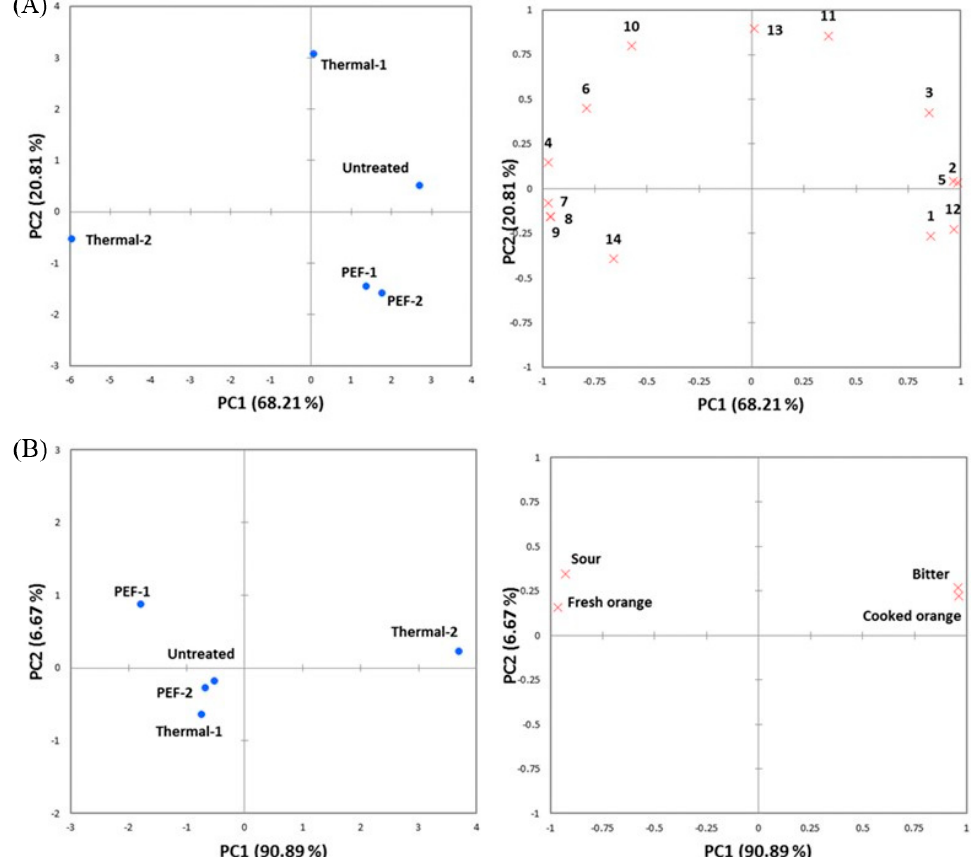
Figure 2. Principal component analyses (PCAs) of pulsed electric field (PEFs) and thermally treated orange juice. ( A ) PCA score plot with sample labeling and PCA loading plot with volatile compound codes. The compound codes are explained in Table 2. ( B ) PCA score plot with sample labeling and PCA loading plot with sensory attributes.